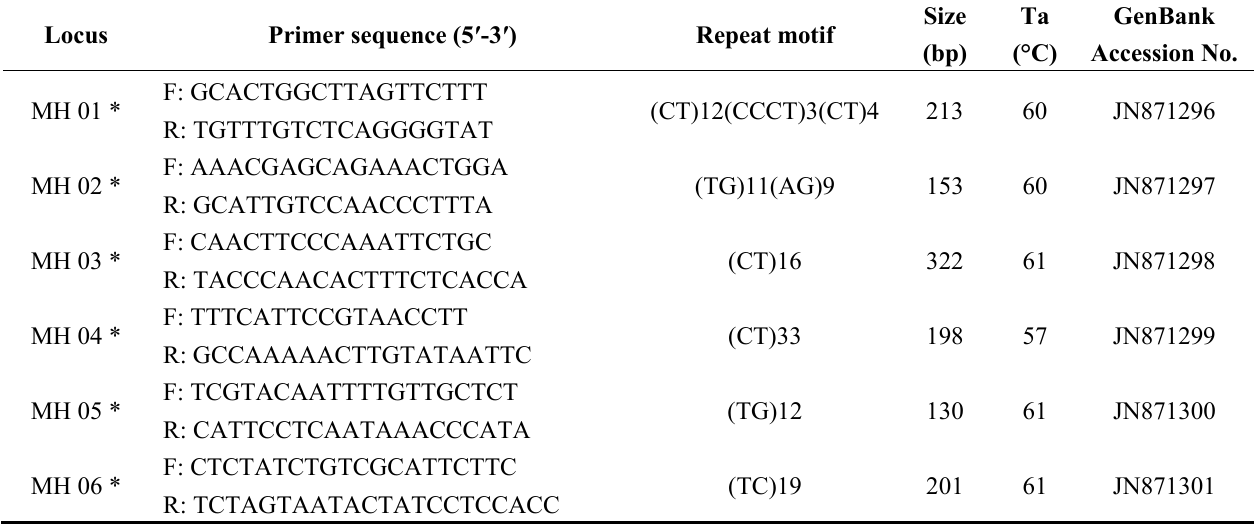
Table 1. Characteristics of 24 microsatellite loci successfully amplified in Luculia yunnanensis . Locus Primer sequence (5 ′ -3 ′